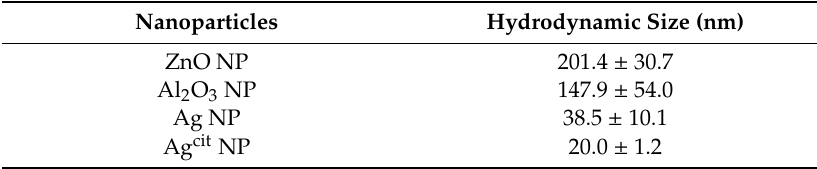
Table 1. Hydrodynamic sizes of nanoparticles (NPs) tested.